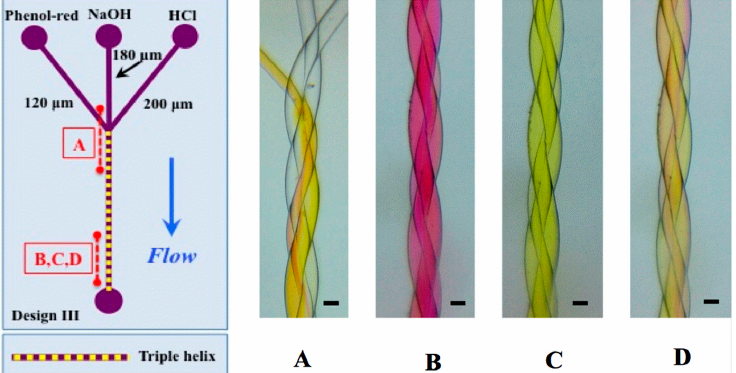
Figure 7. Left : channel design of type III. In ( A – C ): HCl, NaOH are at 2 mM, Phenol red 2 mM, 2 mL/h. Channel diameters in the triple helix are 120, 180, and 200 μ m. Pitch length is 2.5 mm. Scale bar 200 μ m. ( A , C ): inlet in acid-dominated regime (HCl at 2 mL/h, NaOH at 0.5 mL/h). ( B ): base-dominated regime (HCl at 0.5 mL/h, NaOH at 2 mL/h). ( D ): balanced acid-base regime, all flows at 1.5 mL/h. Mixing is evident at the top of ( B – D ) corresponding to a position of 15 mm after channel joint. Note the significant difference in mixing compared to Figure 9 with straight channels.